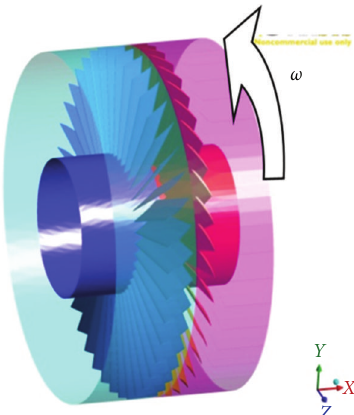
Figure 1: Schematic view of gas turbine stage, showing the hub, the external casing, and the blades (40 stator blades and 40 rotor